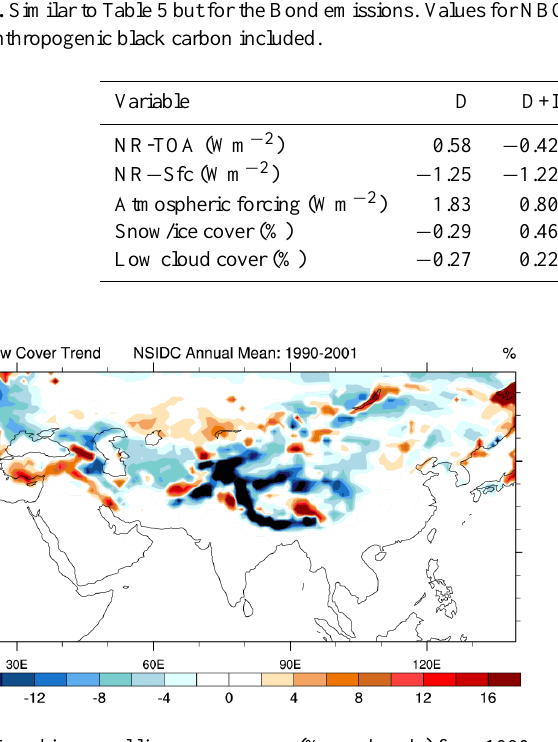
Fig. 5. Trend in annual linear snow cover (% per decade) from 1990 to 2001 as obtained from the National Snow and Ice Data Center (NSIDC) EASE Grid weekly snow cover and sea ice extent dataset (Armstrong and Brodzik, 2005). Trend is based on a least-square linear